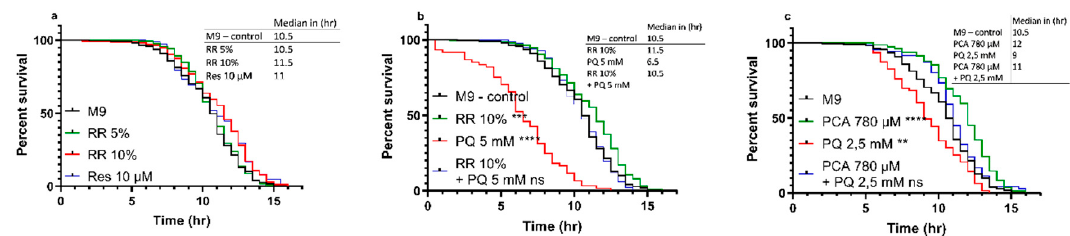
Figure 3. Heat-stress resistance of C. elegans at 37 ◦ C under the influence of RR 5 and 10%, PCA 780 µ M, paraquat 2,5 and 5 mM, and combinations of said e ff ectors over the course of 17 h ( a–c ). For heat-stress experiments, survival was assessed according to the penetration of SYTOX ™ Green nucleic acid stain into dead cells, as previously described, with a minimum of n < 61; log-rank (Mantel-Cox) test; ** p < 0.01, *** p < 0.001, and **** p < 0.0001.